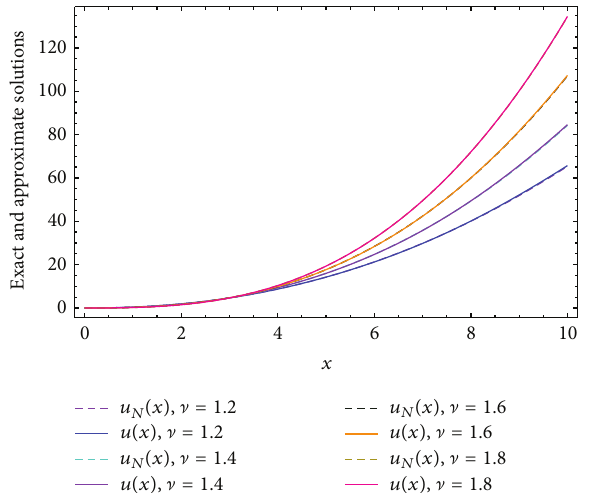
Figure 12: Comparing the exact and approximate solutions at 𝑁 = 12 , 𝛼 = 0 , 𝛽 = 1 , and ] = 1.2 , 1.4, 1.6, and 1.8.